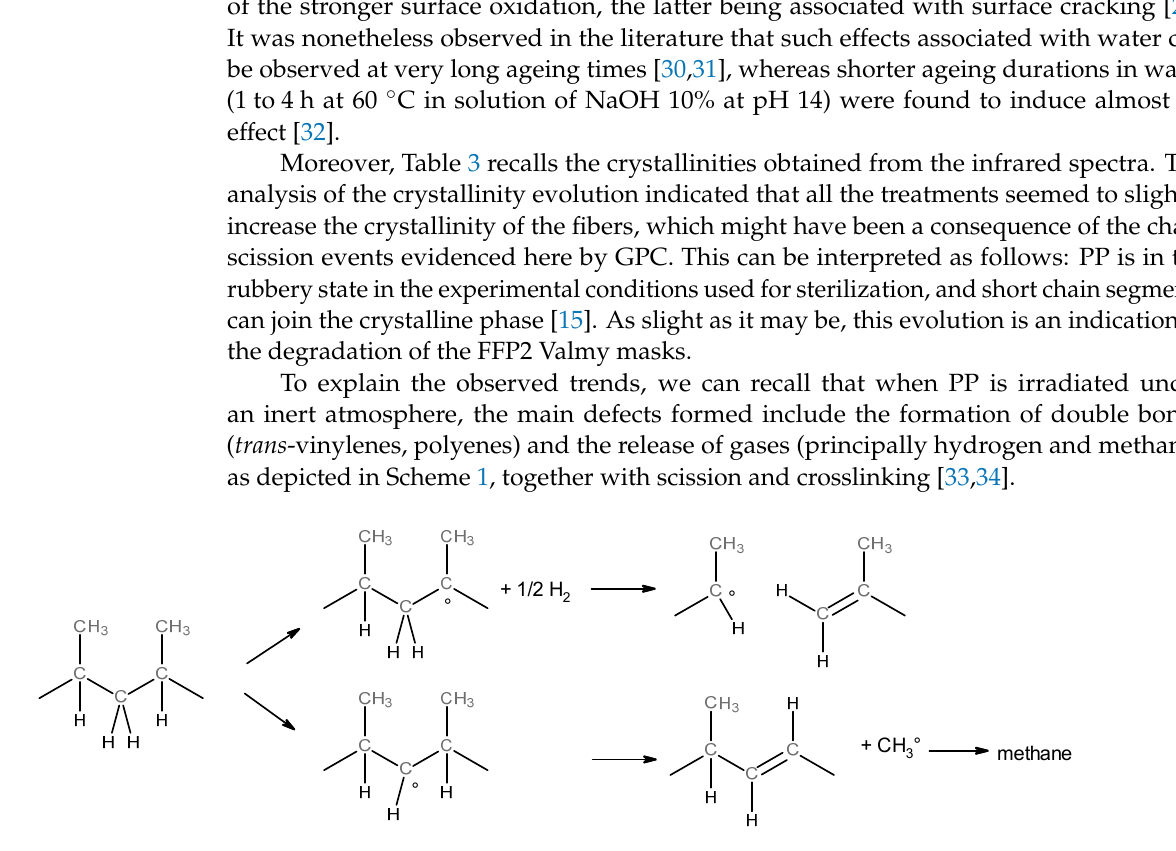
Scheme 1. Mechanism of formation of trans -vinylene, hydrogen and methane from a radiolyzed PP [33,34].